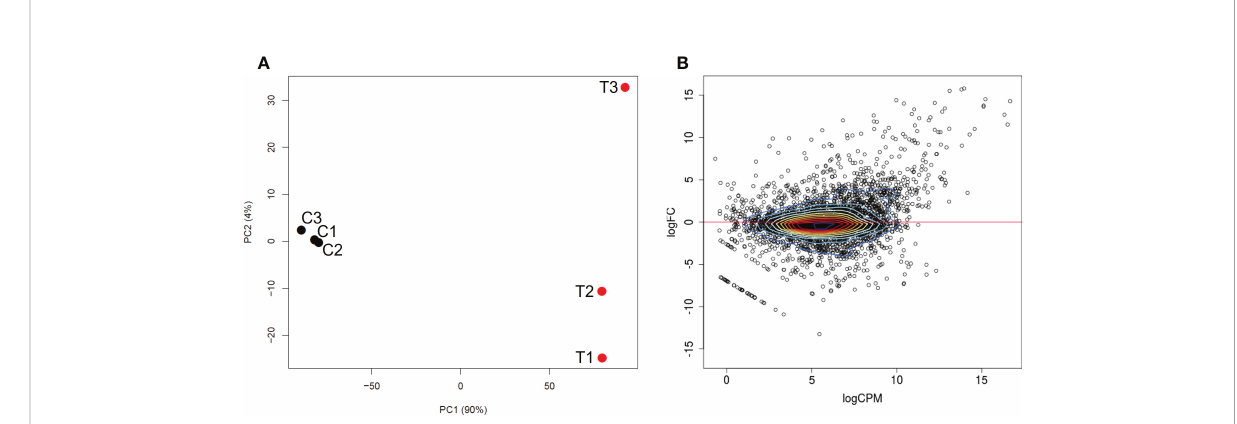
FIGURE 1 Differential transcriptional expression by B. bigemina blood-stages versus kinetes. (A) PCA plot between B. bigemina stages from blood (C1, C2, C3) and versus kinetes (T1, T2, T3). C indicates samples from calves and T indicates samples from ticks. (B) A MA plot shows the relationship of the log 2 fold-change (FC) of B. bigemina blood-stages and kinetes versus the log 2 normalized mean expression counts per million